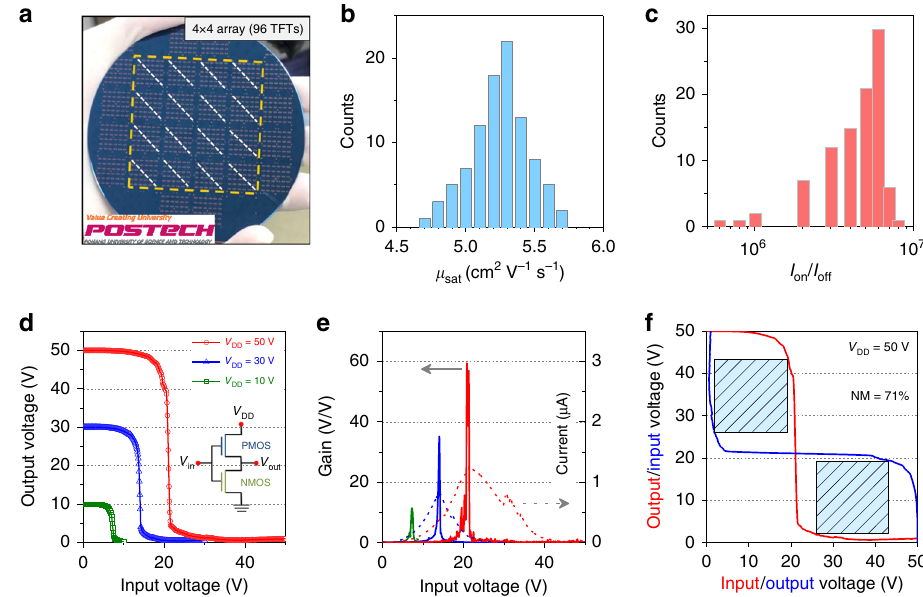
Fig. 4 Wafer-scale uniformity and the CMOS inverter integration with n-channel IGZO TFTs. a Photograph of CuI:Zn 5mol% TFT array on a 4-inch Si/SiO 2 (100 nm) wafer substrate (dot line means measurement area). b , c Statistical results of μ sat and I on / I off obtained from 96 TFTs across the array. d – f Voltage transfer, gain, current characteristics, and noise margin (NM) extraction of the complementary inverter based on n -type IGZO/SiO 2 and p-type CuI:Zn/ SiO 2